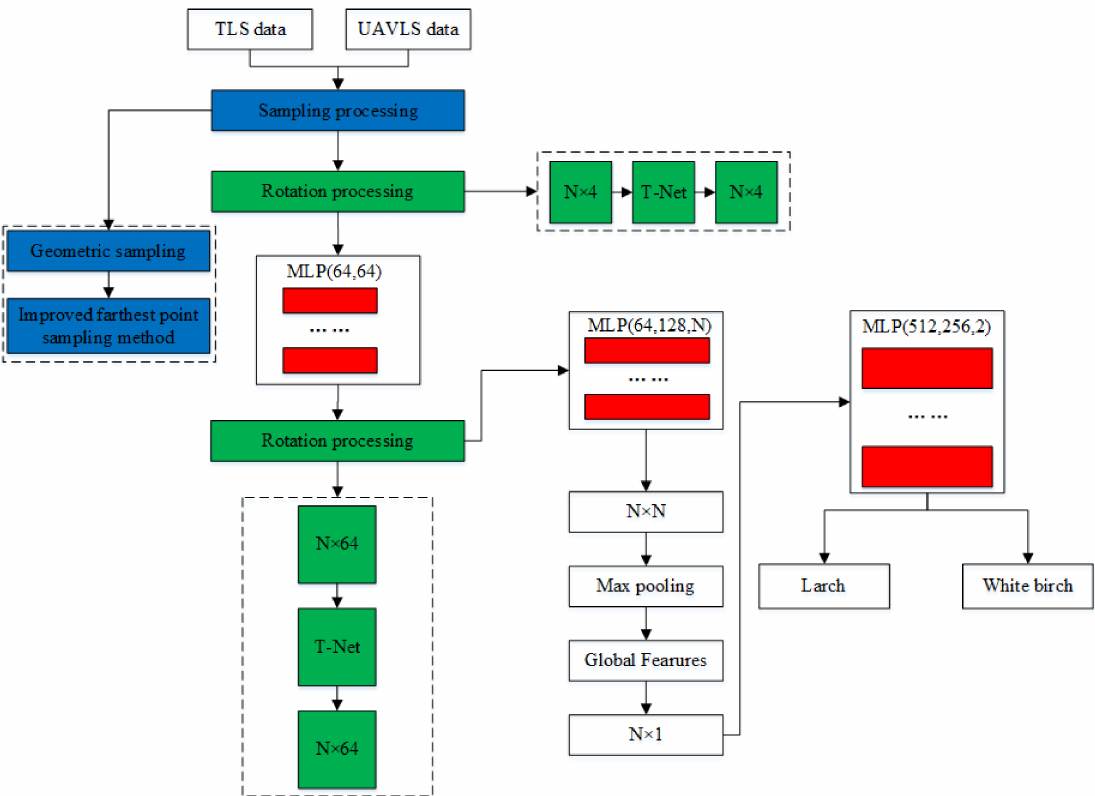
Figure 11. Schematic diagram of network